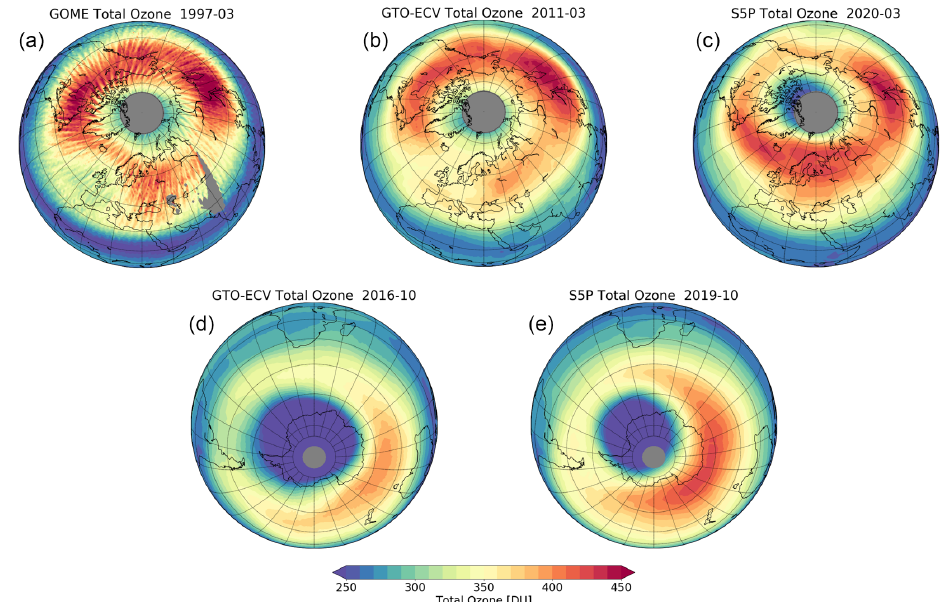
Figure 9. Monthly mean total ozone columns over the Northern Hemisphere in March 1997 (a) , 2011 (b) , and 2020 (c) and the Southern Hemisphere in October 2016 (d) and 2019 (e) . The plot for March 1997 is based on GOME/ERS-2 data with a limited spatial sampling, which induces the orbit structures on the monthly mean values; the plots from 2011 and 2016 are based on GTO-ECV; and the plots from 2019 and 2020 are based on TROPOMI/S5P. Grey areas near the poles indicate missing data during polar night.